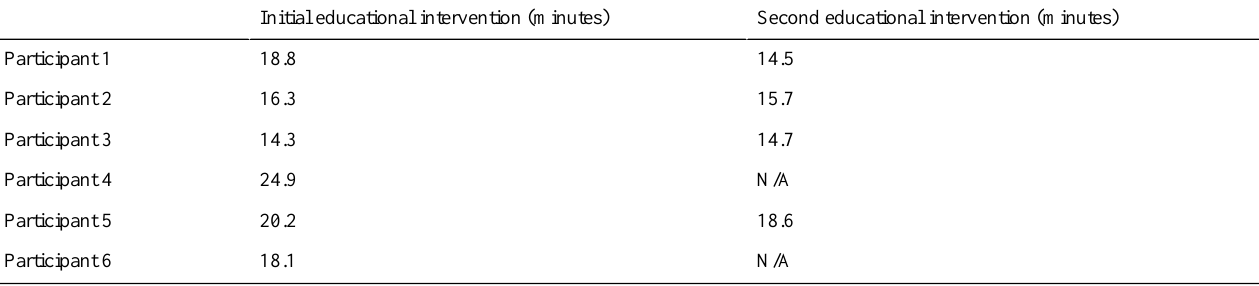
Table 1. Average time taken to complete the MyIDEA